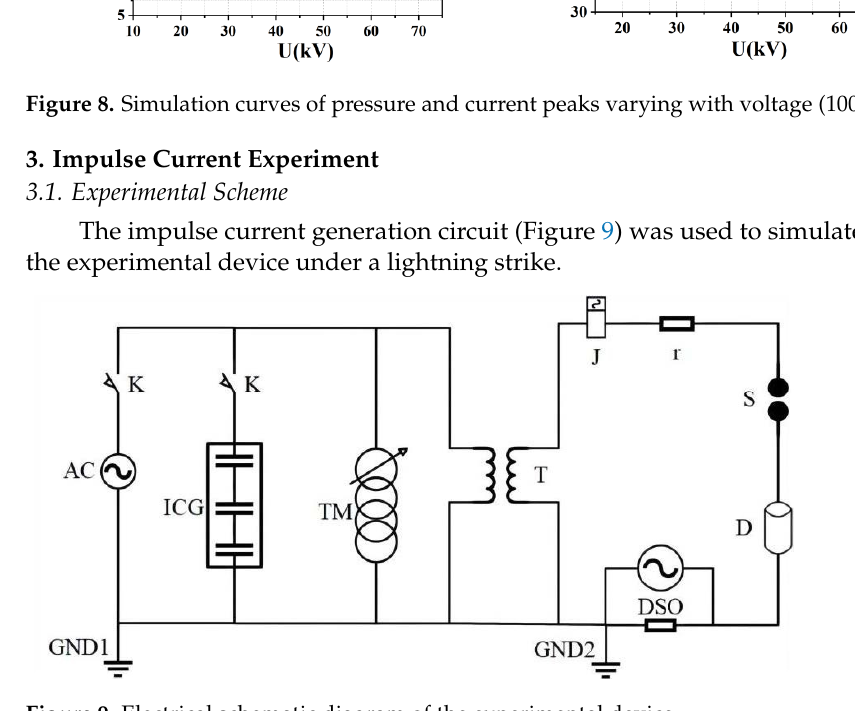
Figure 9. Electrical schematic diagram of the experimental device.